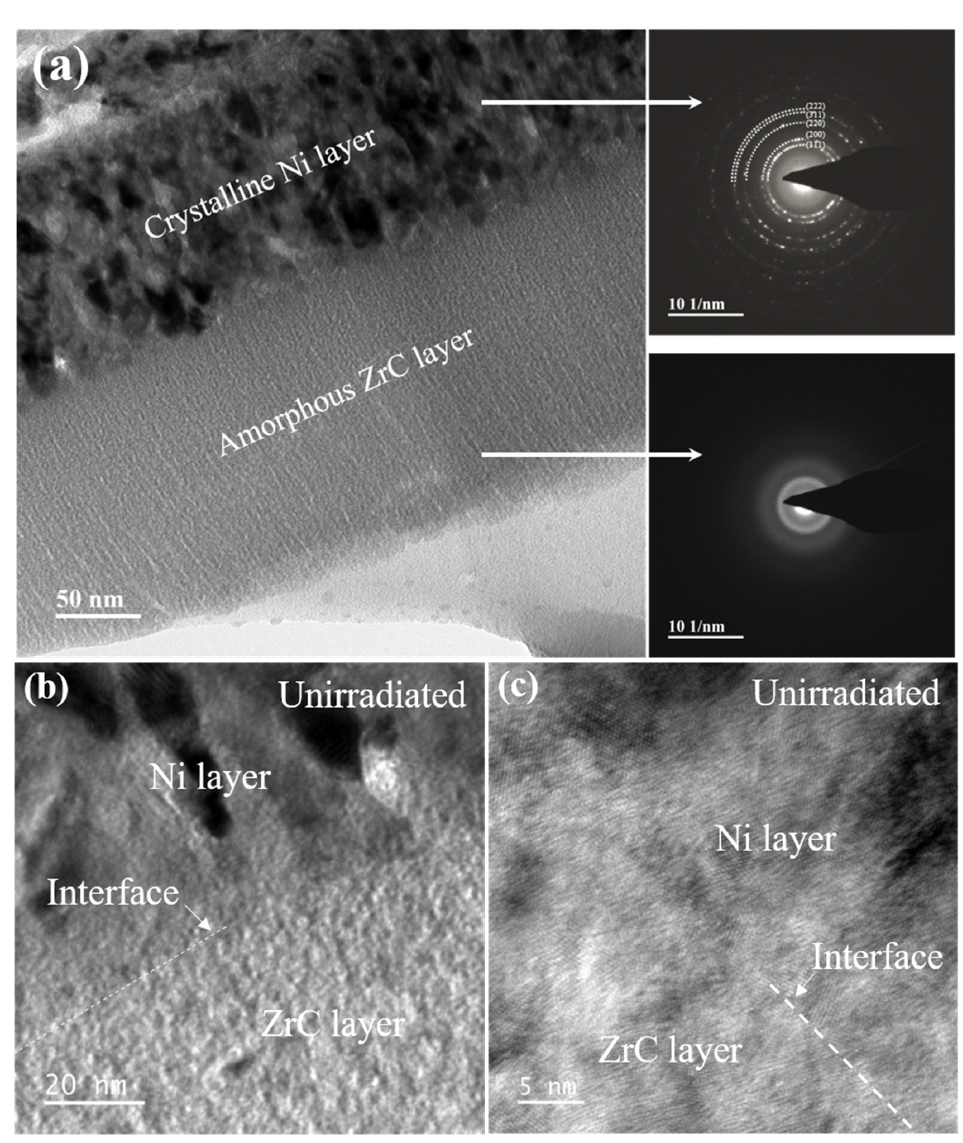
Figure 4. ( a ) The bright-field TEM images and corresponding NBED patterns of pristine amorphous ZrC/nanocrystalline Ni multilayer with single-layer thickness of 100 nm. ( b ) High-magnification bright-field image and ( c ) HRTEM image at the interface of amorphous and crystalline layer.